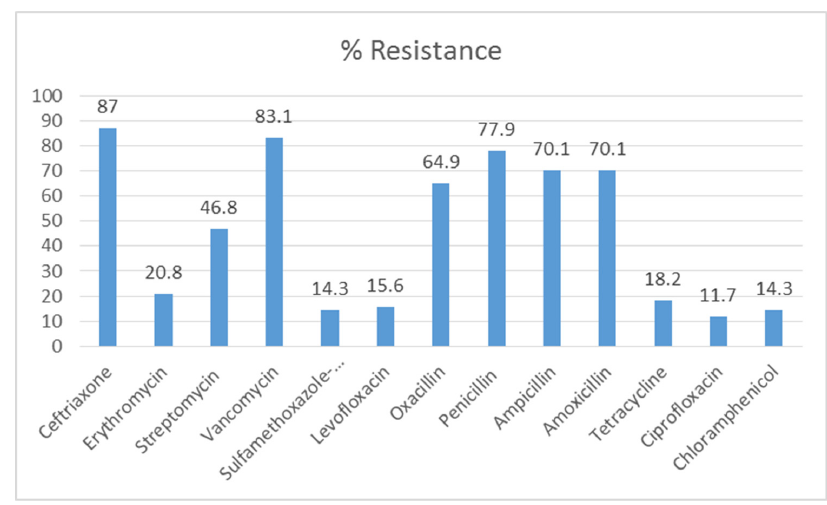
Figure 3. Antimicrobial resistance of S. aureus isolates.